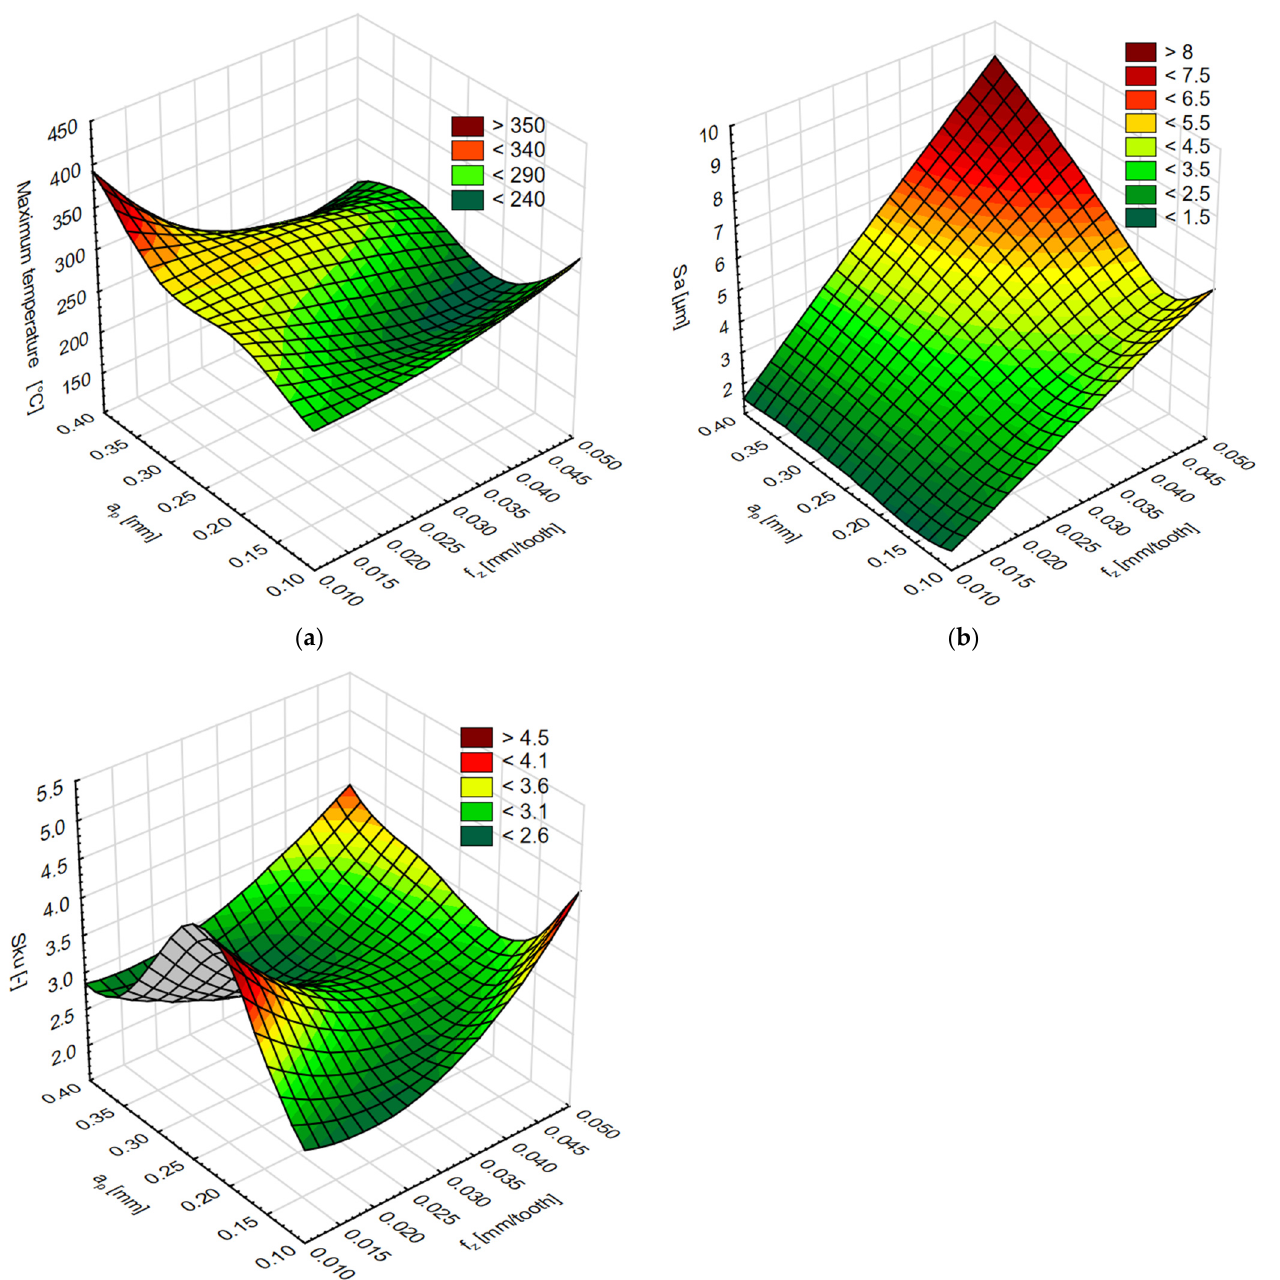
Figure 14. The simulation results of the variable feed per tooth f z and depth of cut a p for ( a ) maximum temperature, ( b ) Sa parameter and ( c ) Sku